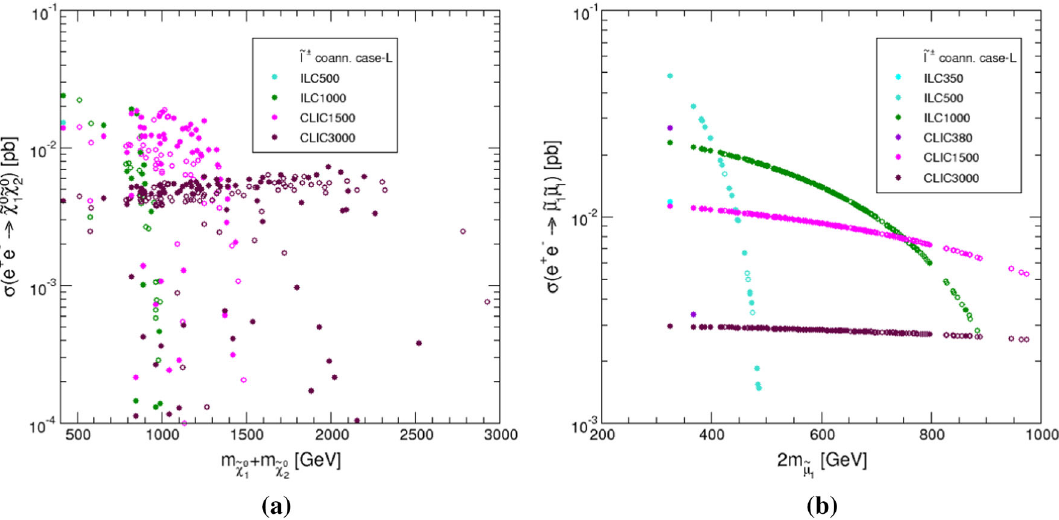
˜ χ 0 (left) and e + e − → ˜ μ 1 ˜ μ 1 (right) in the ˜ l ± -coannihilation Case-L at the ILC and CLIC as a 1 2